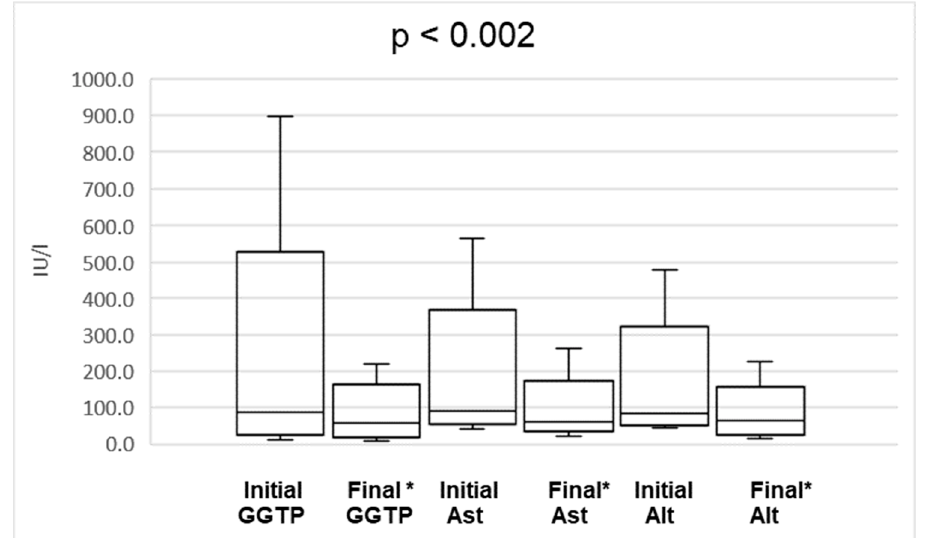
Figure 2. The comparison of initial and final (* at the end of combination therapy) liver enzymes activity. The lower and upper borders of the box indicate 25th and 75th percentiles, respectively. The line within the box depicts the median. The error bars indicate minimum and maximum.